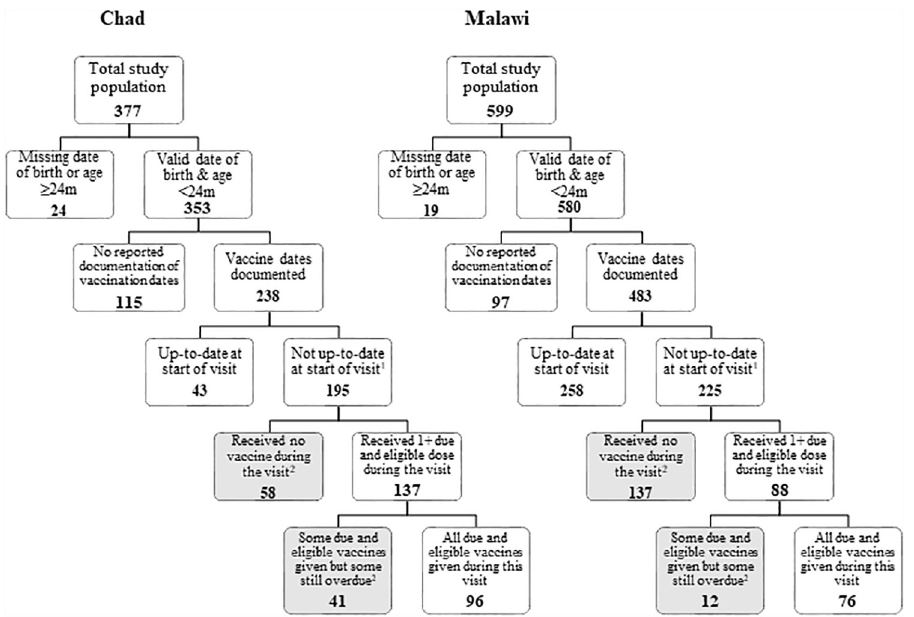
Fig 2. Health-facility-based flow-chart for determining missed opportunities for vaccination (MOV), Chad and Malawi, 2015. 1 All children were without valid contraindications and had 1+ eligible dose due. 2 Missed opportunity for vaccination (MOV): contact with health services by a child (or adult) who is eligible for vaccination (unvaccinated, partially vaccinated, or not up-to-date, and free of contraindications to vaccination), which does not result in the individual receiving all the vaccine doses for which he or she is eligible [9,